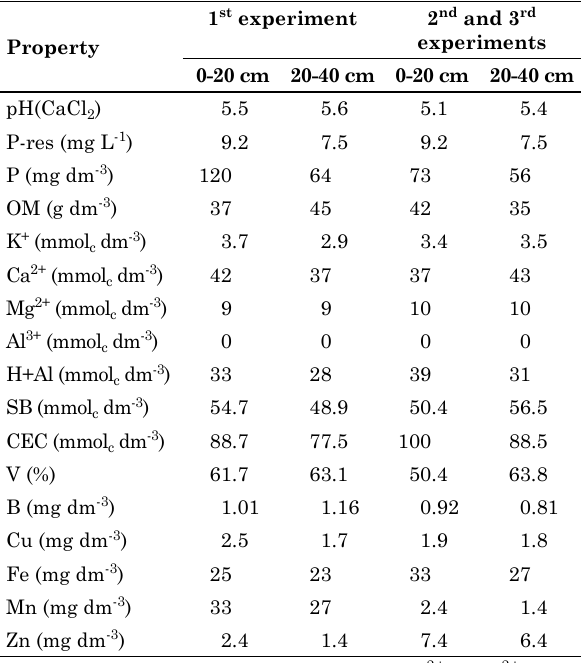
Table 1. Chemical characterization of the soil in the carrot cropping areas